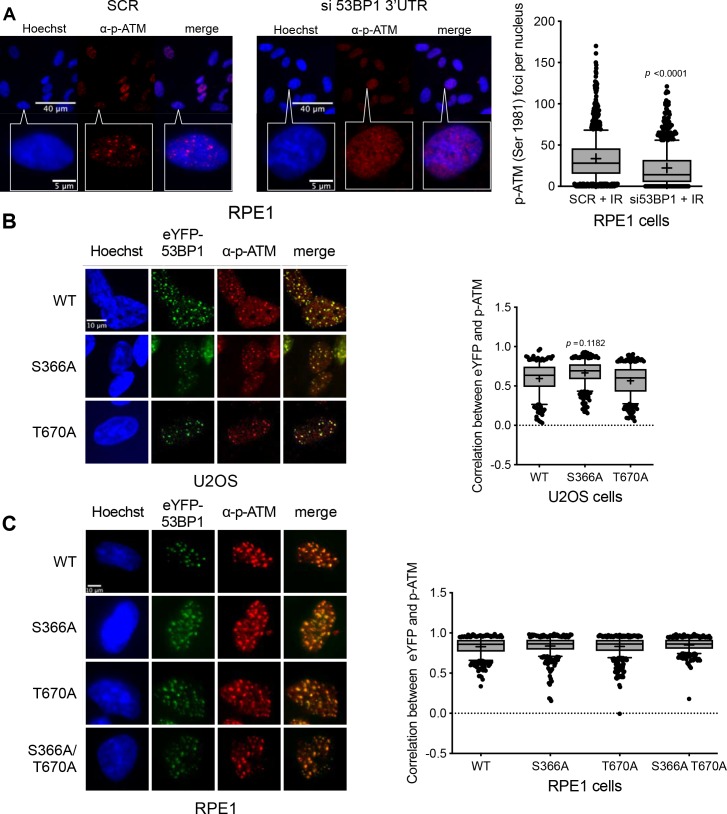
pATM focus colocalisation with 53BP1 is unaffected by mutations in Ser366 or Thr670.(A) Representative pictures of pATM foci formation 2 hr post IR (9Gy) in RPE1 cells after a 72 hr knockdown period with a 3’UTR 53BP1 siRNA. Wide field pictures are taken with an IX70 Core DeltaVision microscope (scale bar, 40 µm) and magnifications display absence of foci in knocked-down cells (scale bar, 5 µm). Boxplots (right) represent the pATM foci counts per nucleus following 53BP1 depletion in RPE1 cells 2 hr post IR (9Gy). The median, mean (+), 10–90 percentiles and outliers are presented. The pATM foci formation decrease after knockdown is considered significant (p<0.0001) by a a Mann-Whitney test. More than 700 nuclei were counted for each case. (B) pATM foci co-localise with 53BP1 in irradiated U2OS cells with siRNA knockdown of endogenous 53BP1 and transfected with siRNA-resistant eYFP-53BP1. co-localisation is not substantially disrupted by the presence of S366A or T670A mutations in 53BP1. Scale bar, 10 µm. Boxplots (right) statistical analysis of images exemplified in B. More than 200 nuclei were counted per case. Median, mean (+), 10–90 percentiles and outliers are represented in boxplots. p values for the mutants relative to wild-type were calculated by a Kruskal-Wallis test corrected by Dunn’s multiple comparison test. (C) as B. but for RPE1 cells. More than 300 cells per case were counted. Scale bar, 10 µm.